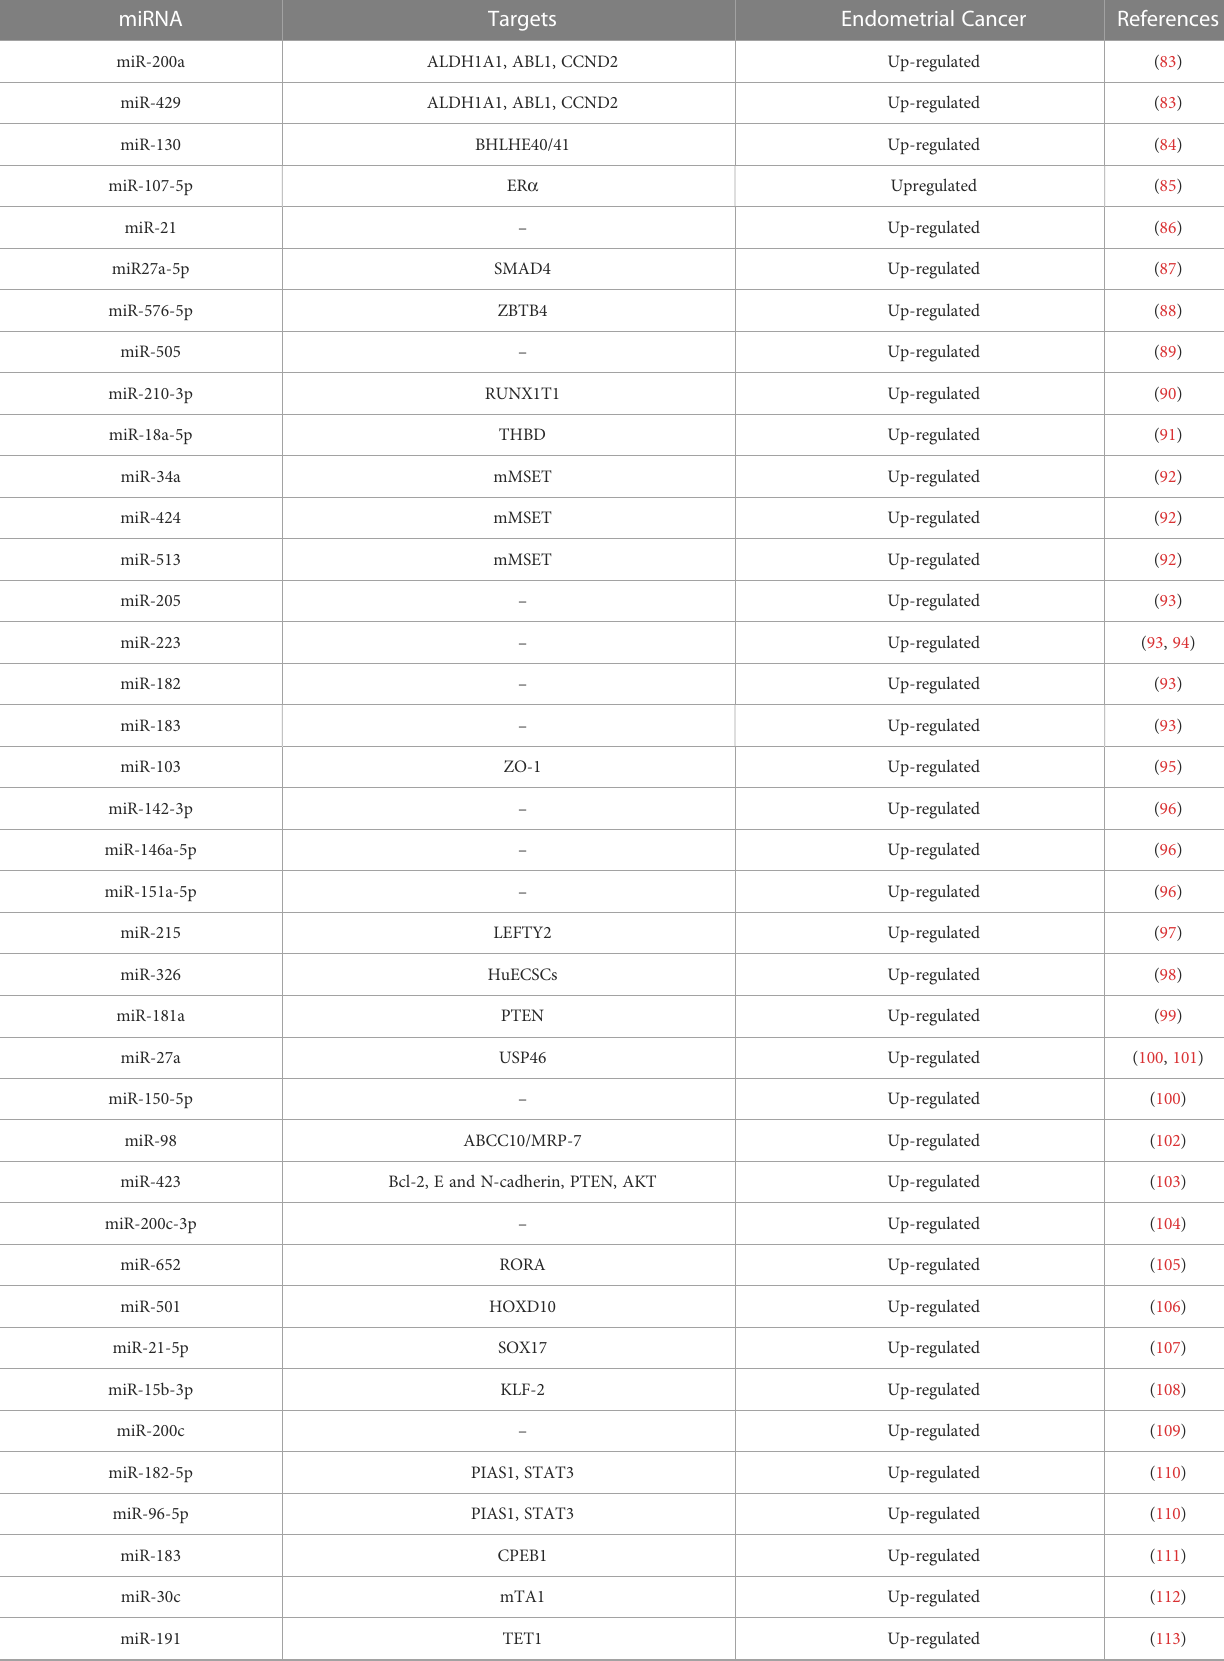
TABLE 1 Targets and status of miRNAs speci fi c to endometrial